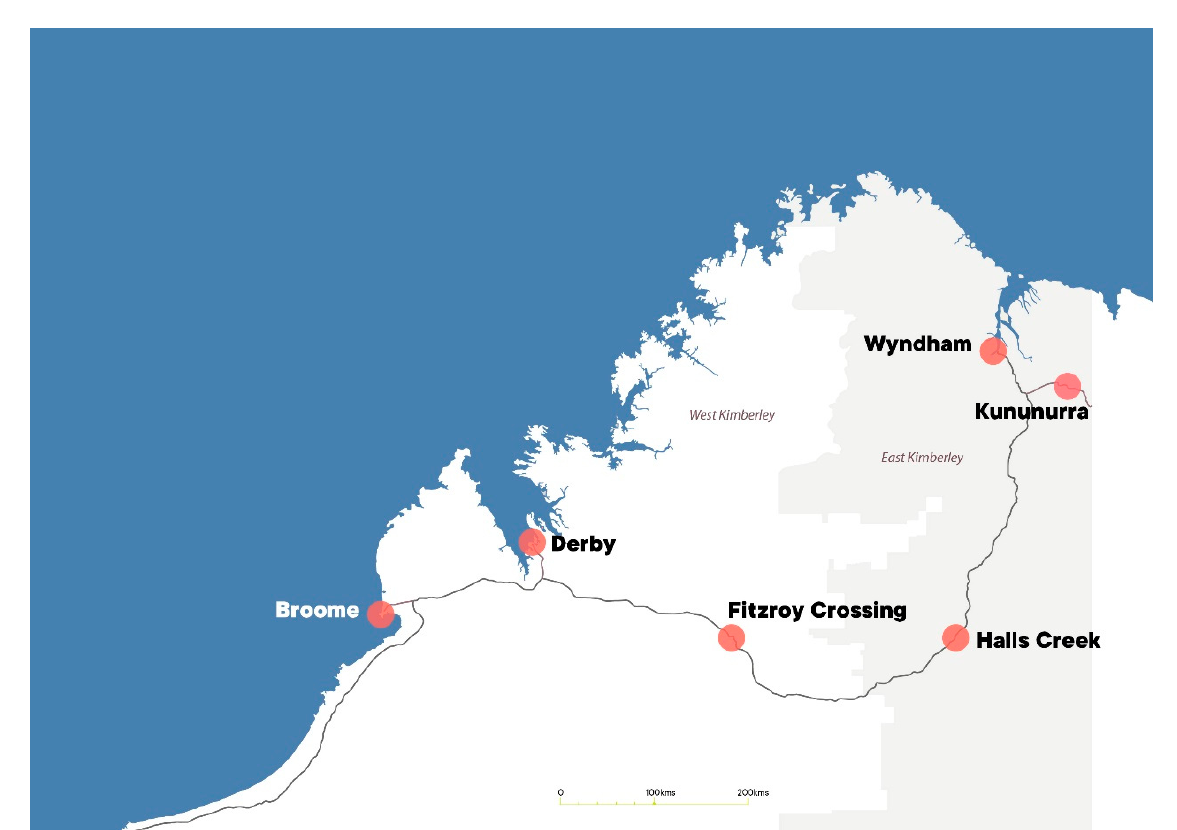
Figure 1. Map of the Kimberley Region, Western Australia.